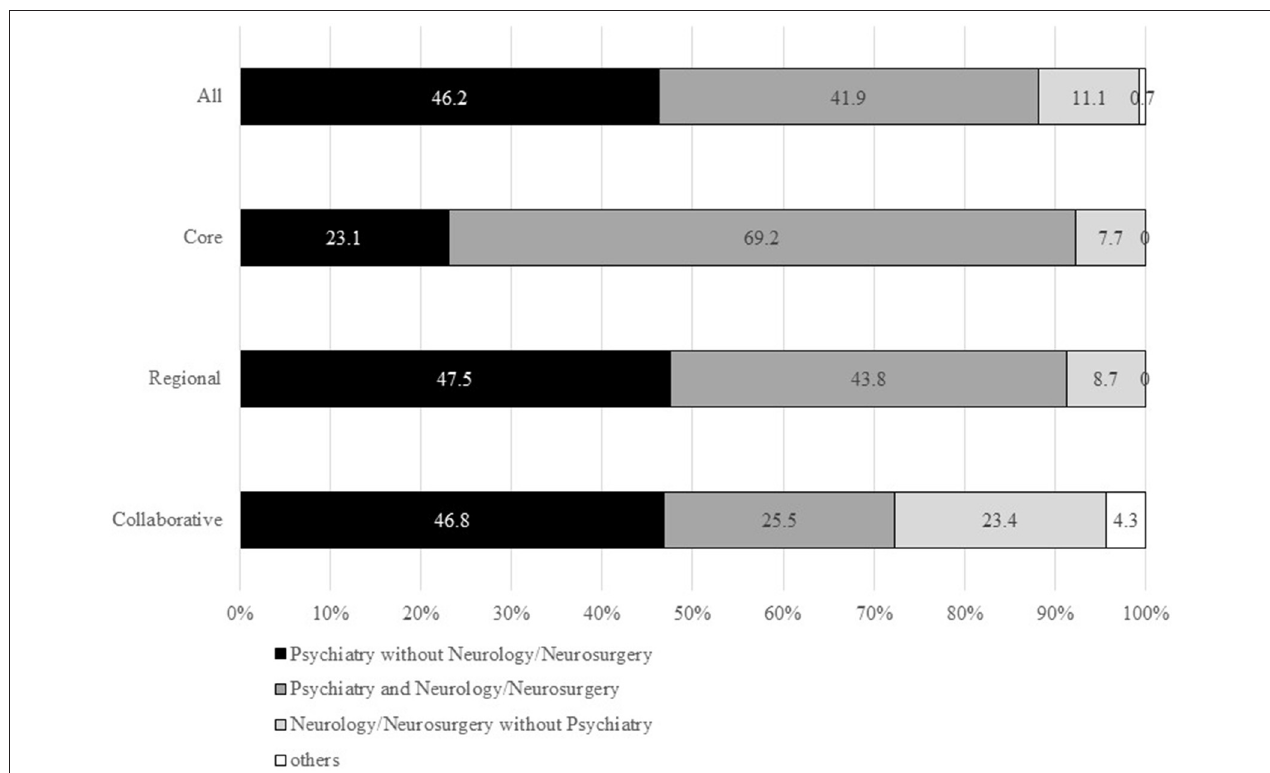
FIGURE 1 | Percentages of departments in MCDs. Department of internal medicine was not included in this figure. MCD, medical center for